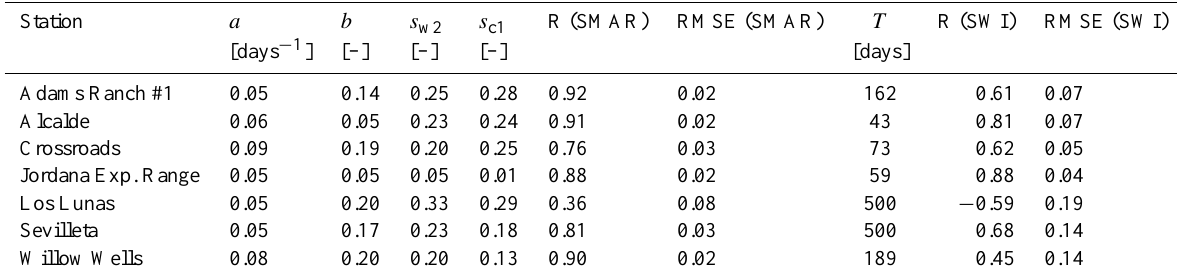
Table 3. Summary of the results of the calibration with the SMAR and SWI methods on the time series of the SCAN database.